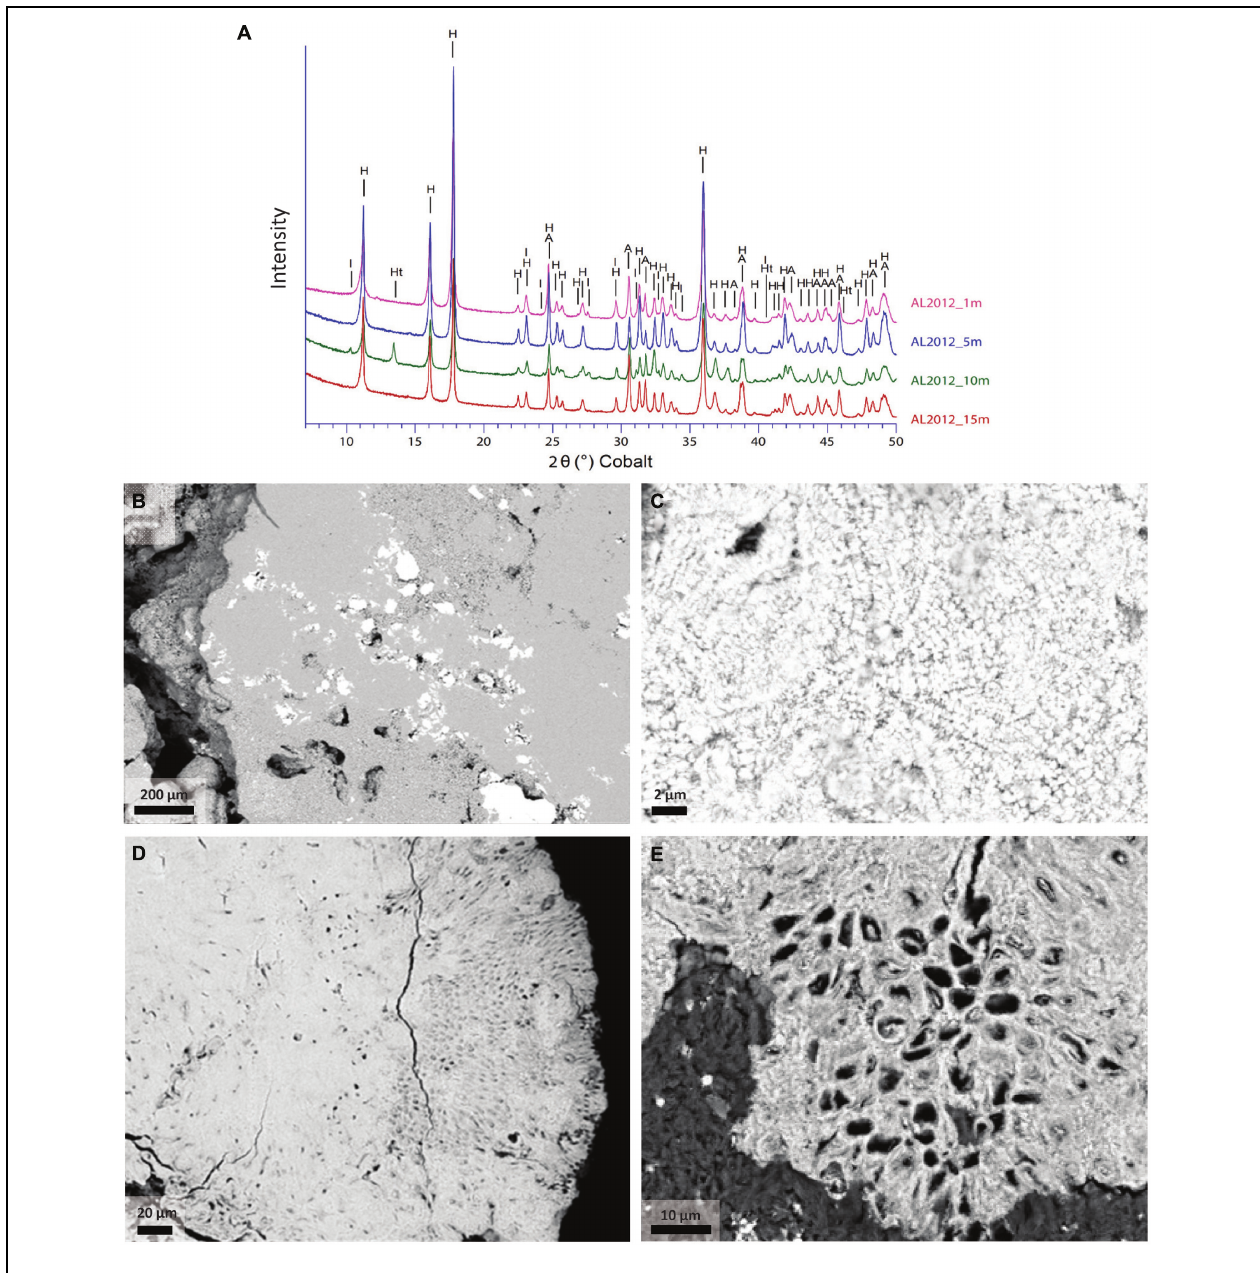
FIGURE 2 | Mineral phases of Alchichica microbialites. (A) X-ray diffractograms of the Alchichica microbialite fragments sampled at different depths on the Northern shore (AL-N samples). (B–E) Scanning electron microscopy (SEM) images of the sample AL-N-10 (10 m depth) showing the most conspicuous mineral phases; hydromagnesite (H), aragonite (A),